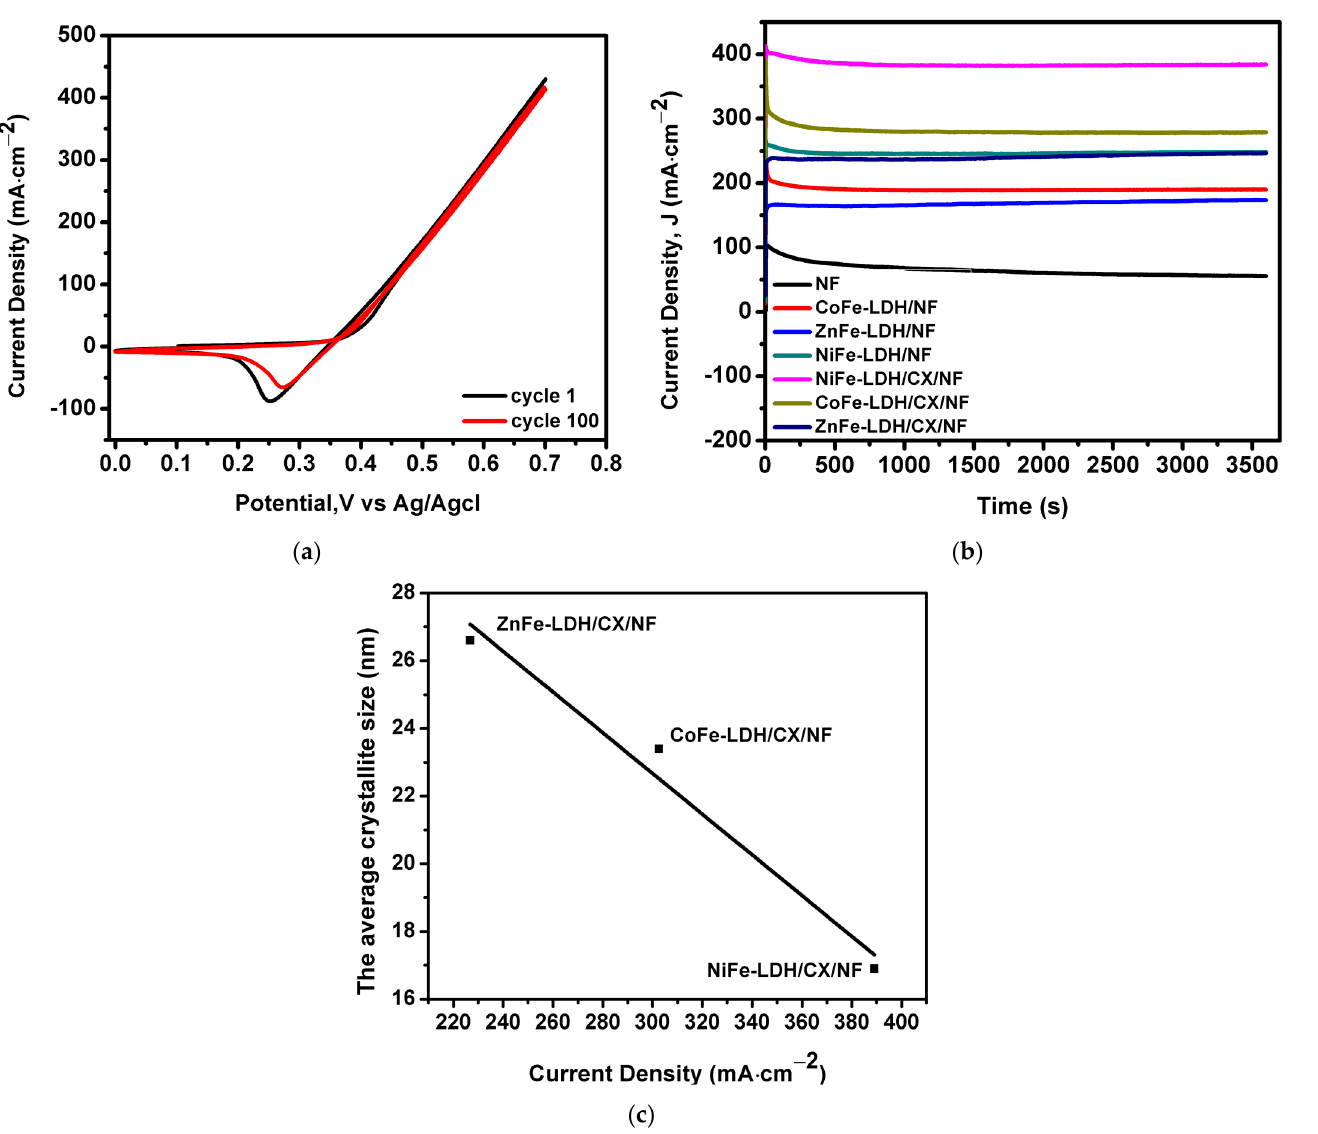
Figure 8. ( a ) Repetitive 100th cycle of NiFe-LDH/CX/NF in 1.0 M KOH + 0.5 M CH 3 OH at a scan rate of 40 mV/s. ( b ) Chronoamperometric response of the synthesized electrocatalysts in 1.0 M KOH + 0.5 M CH 3 OH at 0.7 V and ( c ) the crystallite particle size of the modified electrodes versus their electrochemical activity. Table 3. Comparison of current densities, electrolyte, and applied potential with several reported electrocatalysts for methanol oxidation.